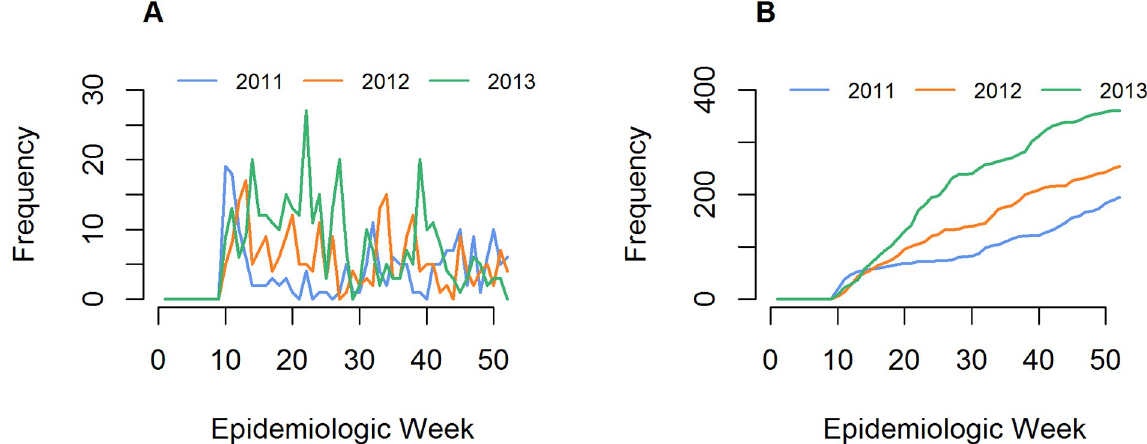
Fig 1. Suspected monkeypox cases in Tshuapa Province, 2011–2013. Case counts by epidemic week (A) and cumulative case counts (B) for the study years. Under the current operational scheme, health care workers anecdotally note when there is an unexpected increase in cases without systematically considering past case